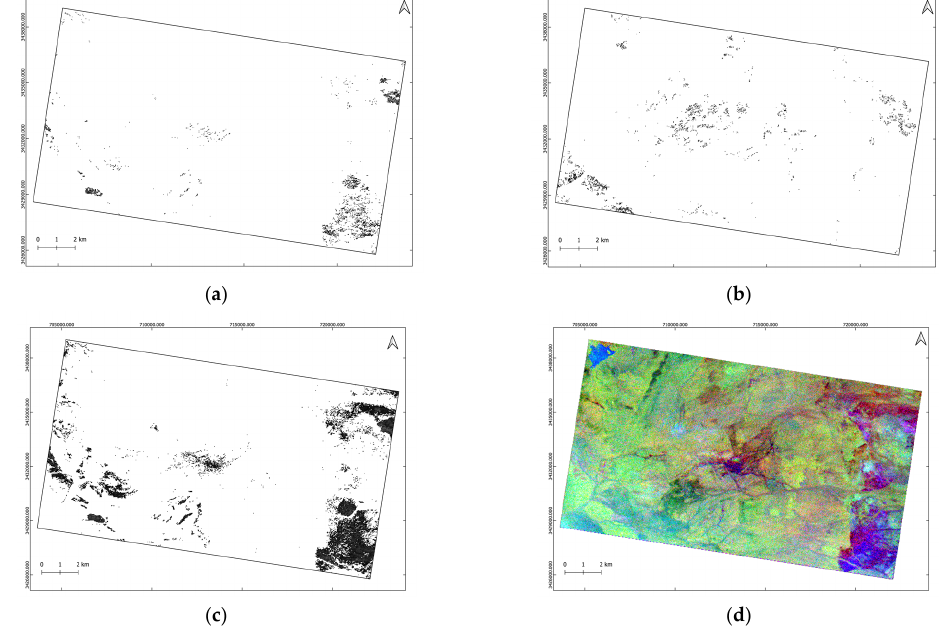
Figure 5. ( a ) PC4 image, ( b ) PC5 image, ( c ) PC7 image (target areas are represented by black pixels), ( d ) RGB color combination of PC4, PC5, PC7 (The threshold values were set to 0.28, 0.33 and 0.42 for PC4, PC5 and PC7, respectively).